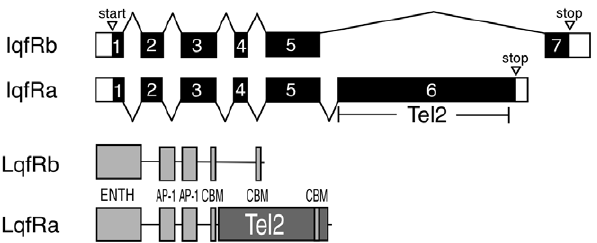
Figure 1. lqfR gene products. At top is a diagram of the two lqfR mRNAs formed by alternative pre-mRNA splicing. Exons 1–7 are indicated by bars and introns by bent lines. The black region in each transcript is the open reading frame. The larger transcript, lqfRa , contains exon6 which encodes Tel2. At bottom are the protein products of each mRNA. ENTH=Epsin N-terminal homology domain, AP- 1=binding motif for the Clathrin adapter AP-1, CBM=Clathrin binding motif.